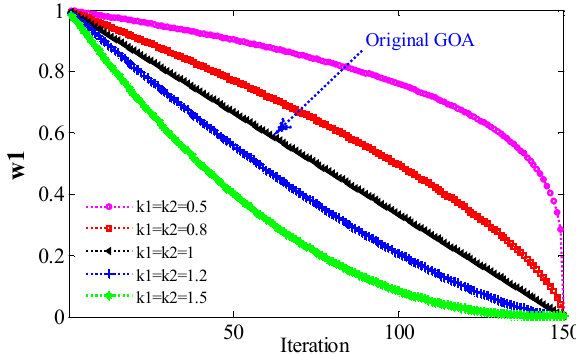
Figure 1. The relationship between ω 1 and parameters k 1, k 2.